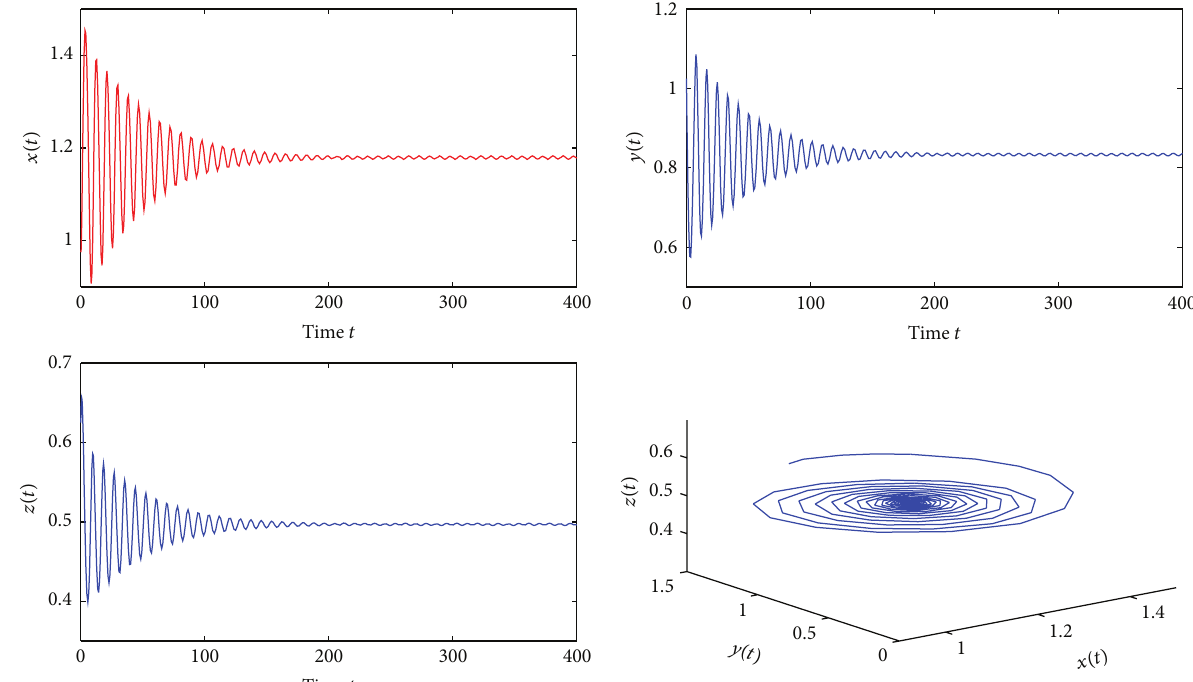
Figure 1: 𝐸 ∗ is asymptotically stable for 𝜏 1 = 1.38 < 𝜏 10 = 1.4887 with initial values 0.975, 1.025, and 0.625.